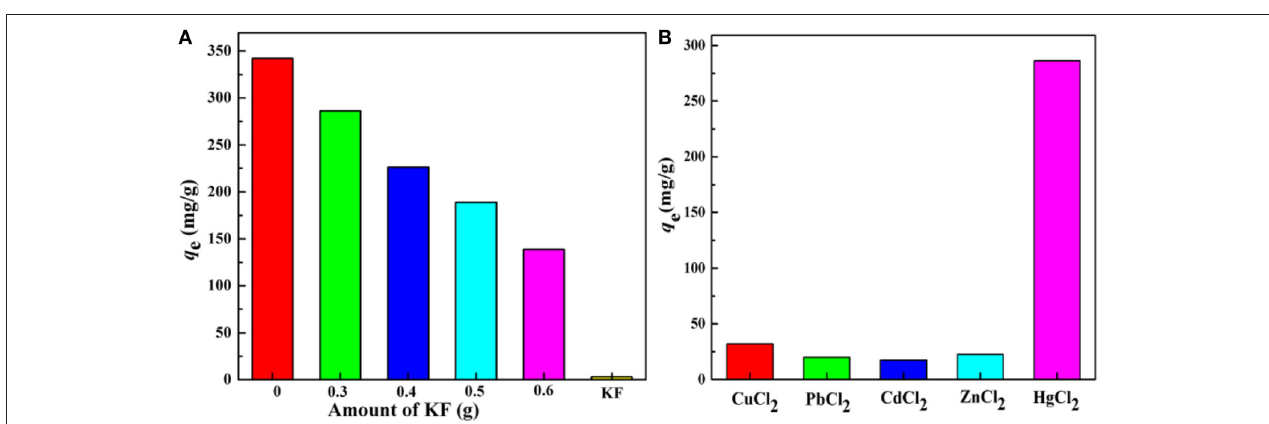
FIGURE 6 | (A) The effect of the amount of KF on adsorption capacity and (B) Adsorption capacities of KF@VIM/EGDMA adsorbents for various divalent heavy metal ions. Adsorption experiments: C 0 : 300mg/L; sample dose: 20mg/25mL; pH: 5.5; temperature: 30 ◦ C; equilibrium time: